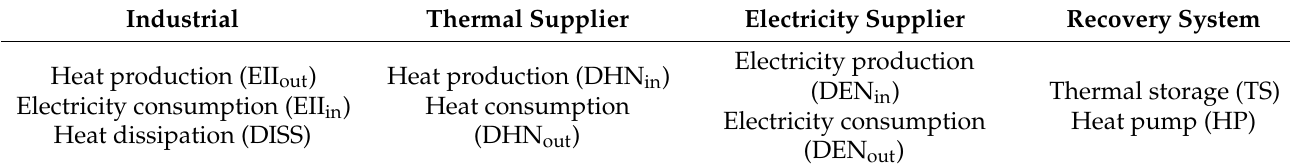
Table 1. Presentation of the energy units in the use case and their related